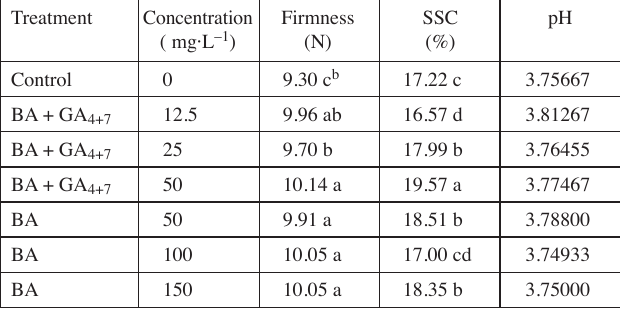
Tab. 2: Effects of pre-harvest benzyladenine (BA) and BA + gibberellin (GA